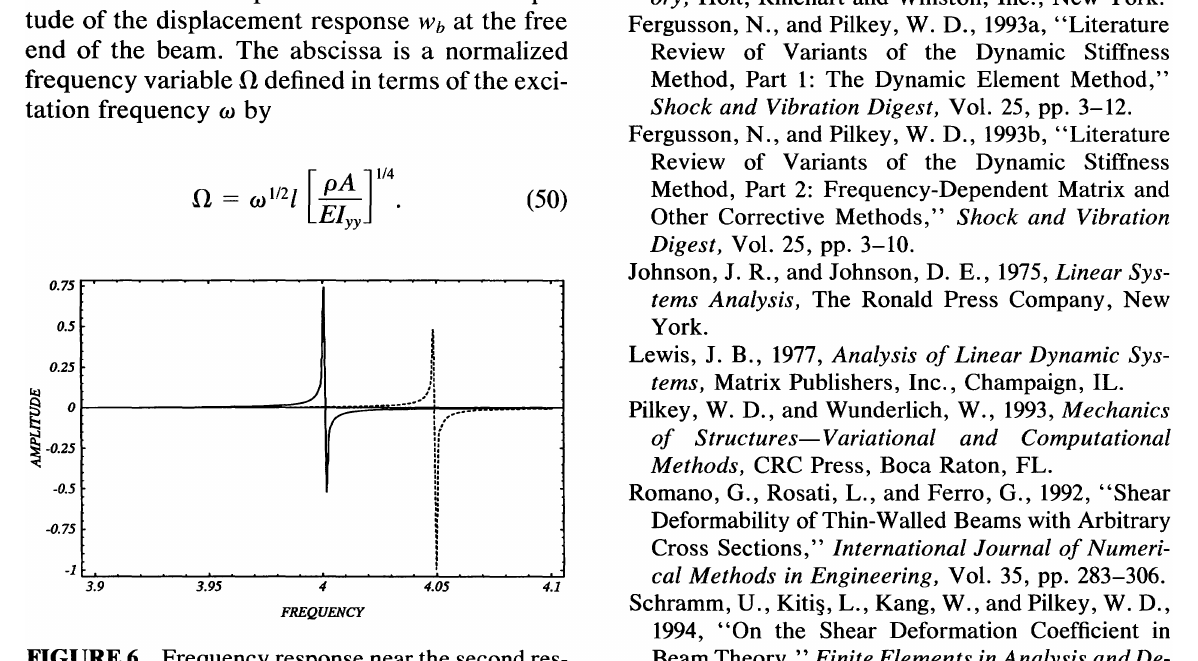
FIGURE 6 Frequency response near the second res onant